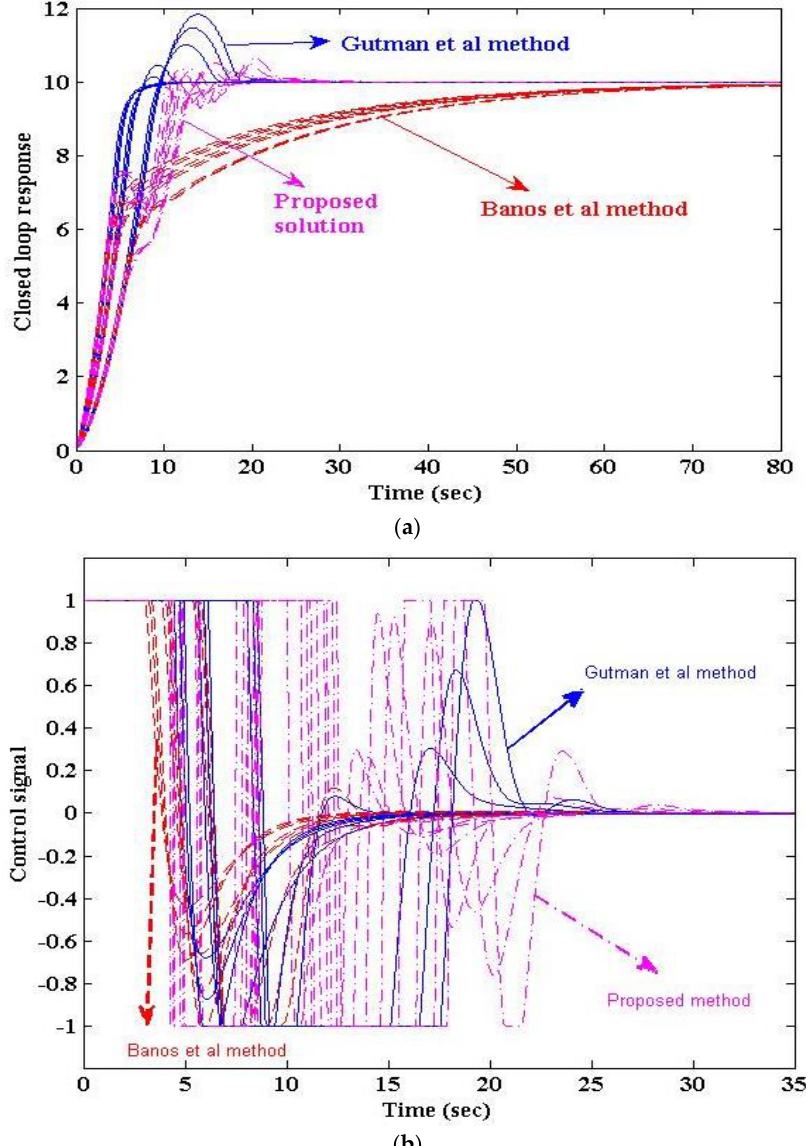
Figure 9. Comparison of the closed-loop system (for 15 randomly generated plants) with anti-windup controller for di ff erent methods; ( a ) closed-loop system for a step reference r ( t ) = 10 × 1( t ), ( b ) saturated control